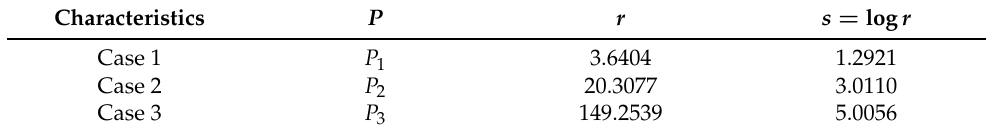
Table 2. System entropy of systems with three different systematic characteristics.